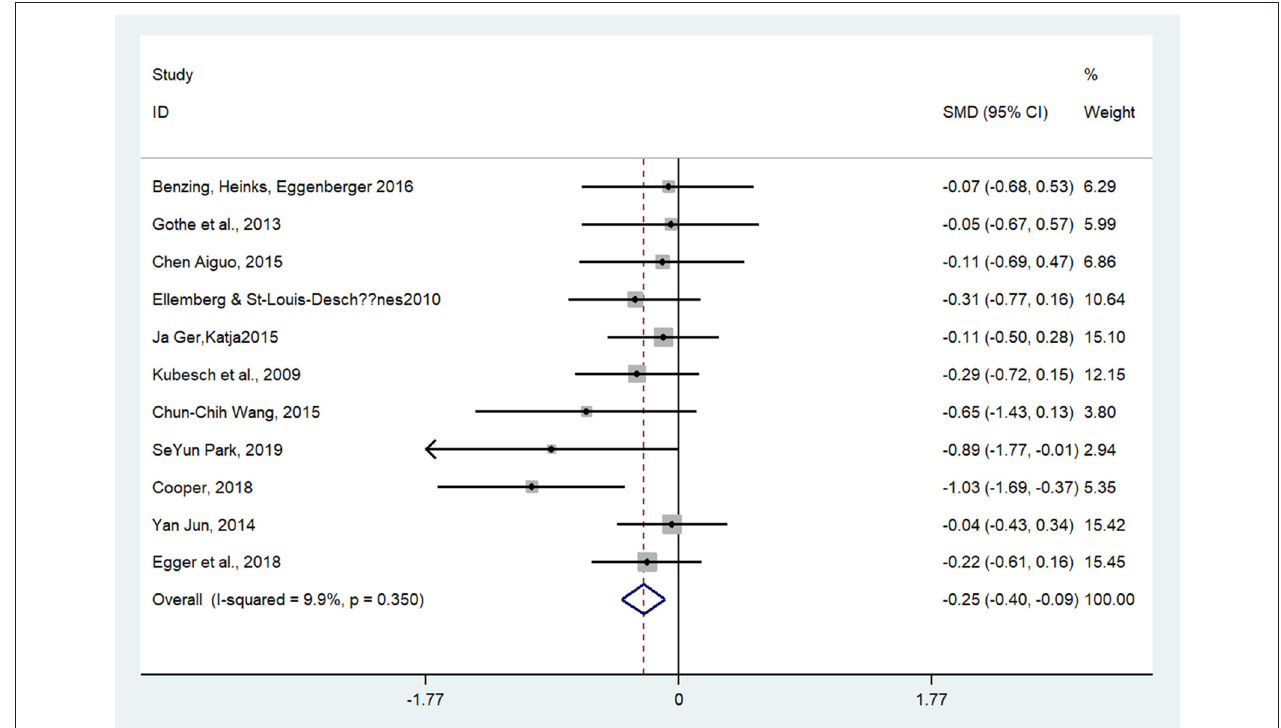
FIGURE 2 | The effect of acute exercises on inhibitory control (SMD = standardized mean difference; CI = confidence interval).